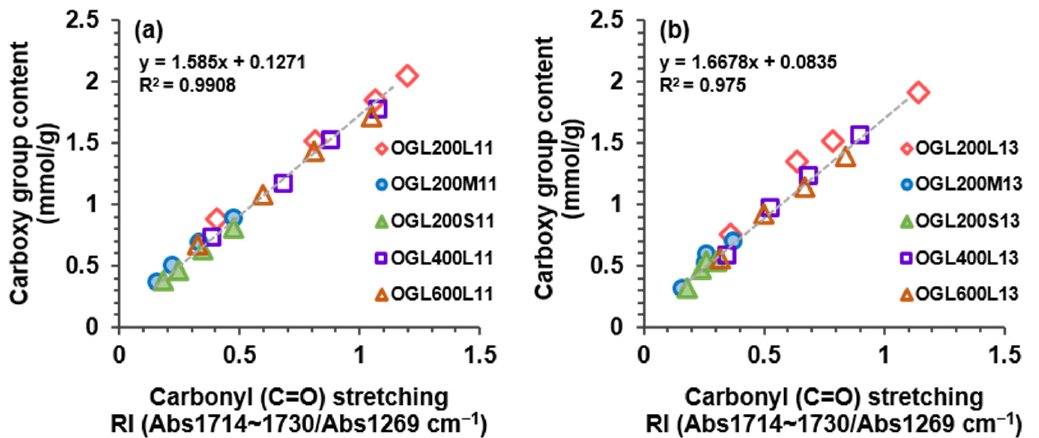
Figure 7. Correlation between the values of carboxy group content determined through potentiometric titration and RI values of the carbonyl absorption band of ( a ) OGL11 and ( b ) OGL13 series through the room-temperature H 2 O 2 -mediated oxidation treatment.